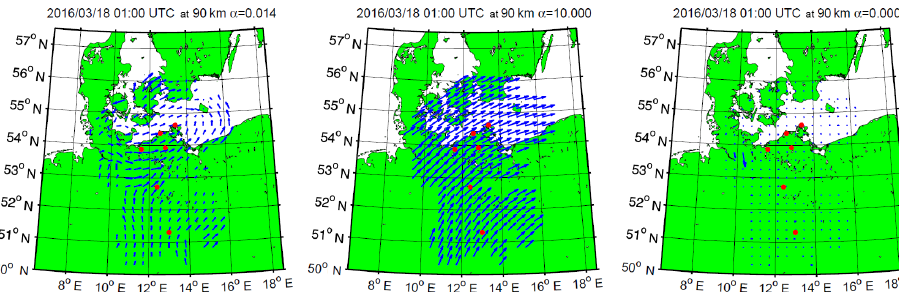
Figure 5. Comparison of 2-D wind fields for three different α = 0 . 014, α = 10, and α = 0 . 000001. The length of the arrows between the images does not scale.